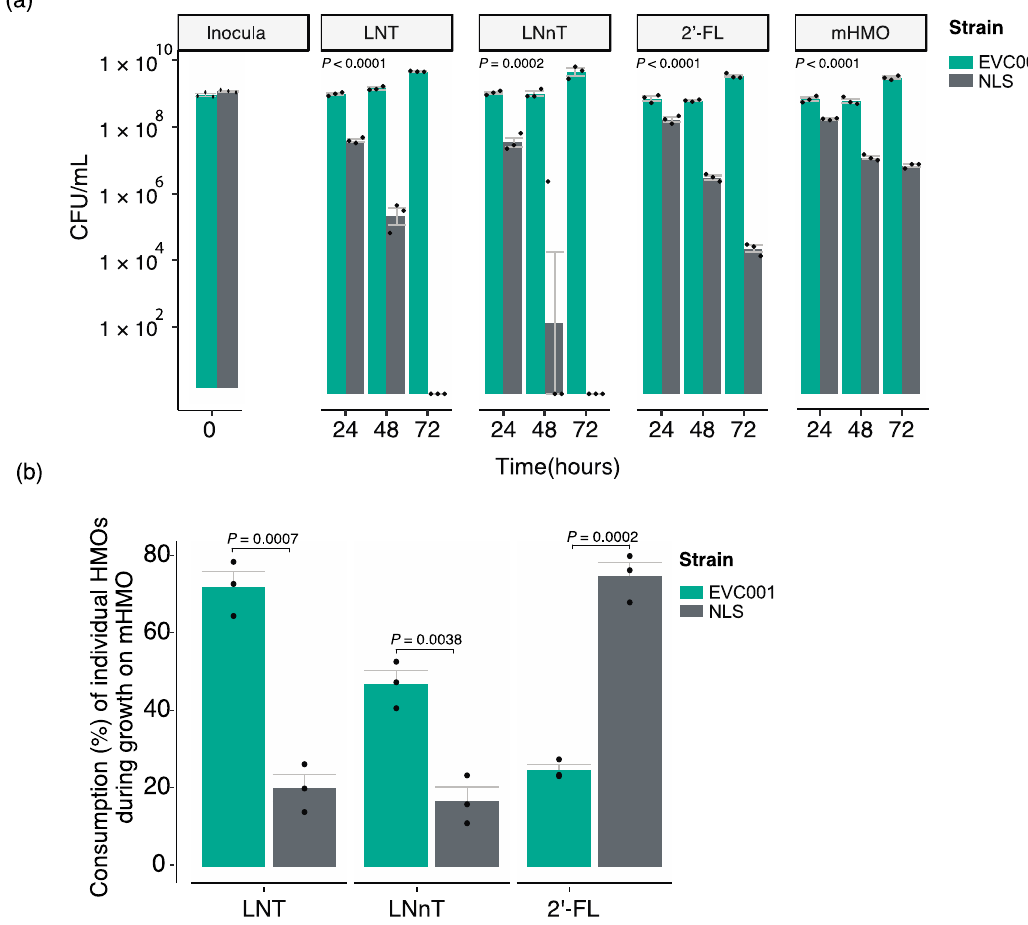
Figure 4. ( a ) In vitro competition experiments between the B. infantis strains EVC001 and NLS in the HMO standards lacto- N -tetraose (LNT), lacto- N -neotetraose (LNnT), 2 (cid:48) -fucosyllactose (2 (cid:48) -FL), or an equal combination of all three (mixed HMO (mHMO)). ( b ) Percent consumption of individual HMO standards by B. infantis EVC001 and B. infantis NLS during growth on mHMO. Statistical significance of strains in competition was determined by two-way repeated-measures ANOVA with Holm–Sidak multiple comparison adjustment. Significant differences in percent consumption were determined by Student’s t -test.